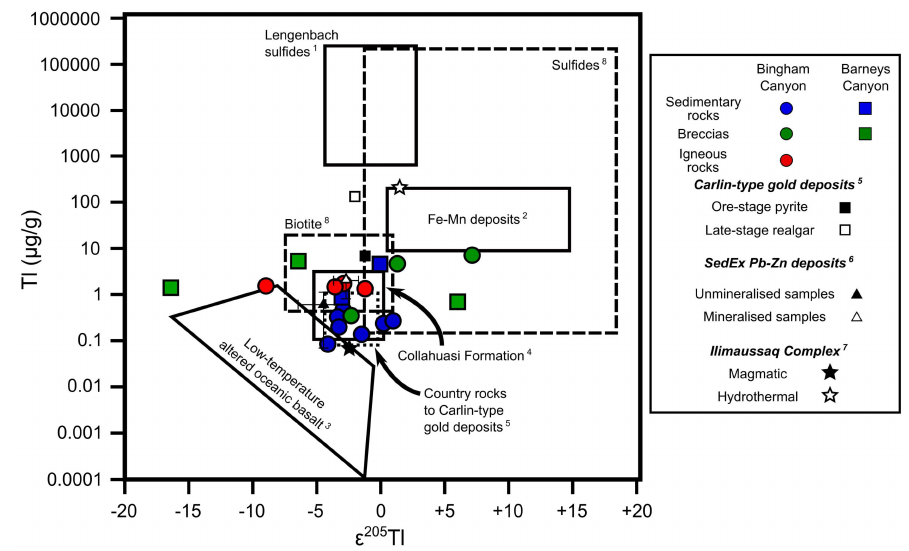
Figure 7. A plot of Tl concentration ( µ g/g) vs ε 205 Tl in samples from the Bingham Canyon district (this study) compared to literature data: 1 [56]; 2 [52,53]; 3 [39,40]; 4 [48]; 5 [54]; 6 [57]; 7 [55]; 8